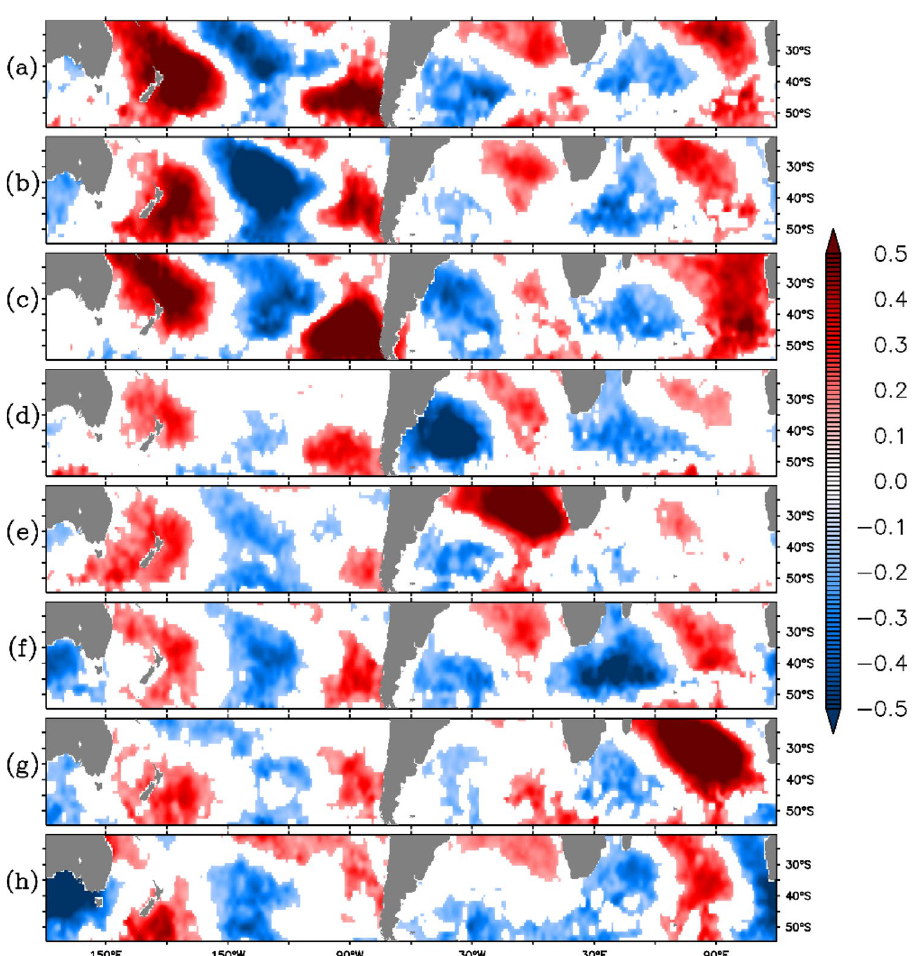
Figure 2. Correlation maps for the time series of points marked in green in Fig. 1 with reconstructed SST anomaly (after removal of first EOF mode related SST anomaly). ( a )–( h ) panels refer to points (i)–(viii) respectively presented in Fig. 1. Panel ( b ), ( d ), ( f ), and ( h ) are inverted to keep the same signs of correlation in the same location for all the plots. Values satisfying 99% confidence interval are